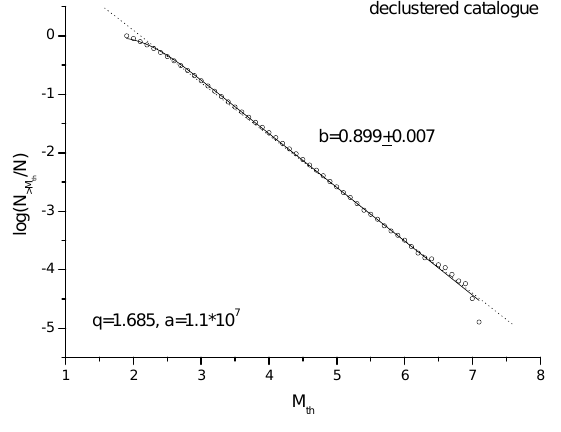
Normalized cumulative magnitude distribution of the declustered crustal Taiwanese seismicity (open circles) and fitting curve (solid line). The values of the parameters are q =1.685 and a =1.1 × 10 7 . The dotted line indicates the Gutenberg-Richter rela- tionship, with b =0.899.